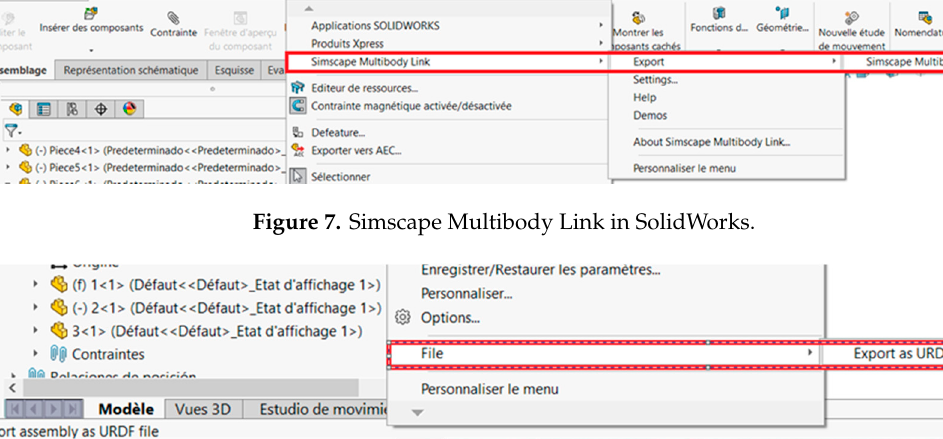
Figure 7. Simscape Multibody Link in SolidWorks.